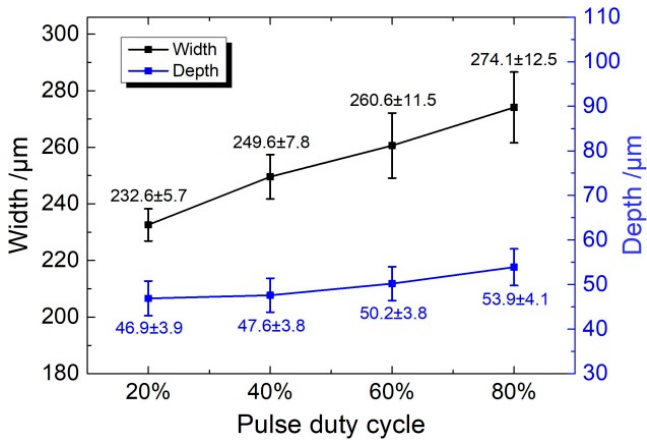
Figure 12. The dimension of micro-grooves generated with different pulse duty cycles ( P in = 0.8 MPa, U = 35 V, f = 1 kHz, t on = 20 s).